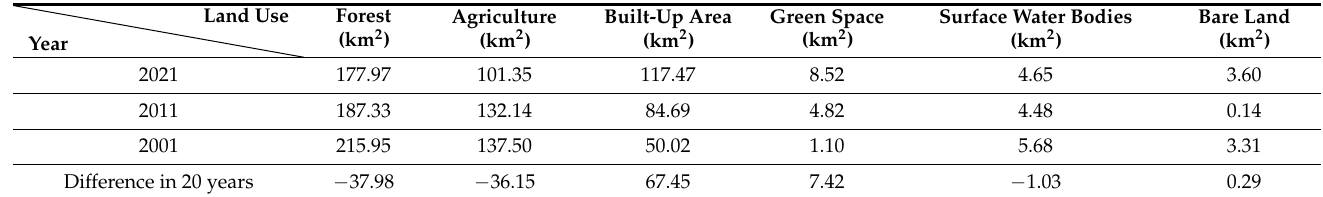
Table 5. Area covered by different land uses during years 2001, 2011 and